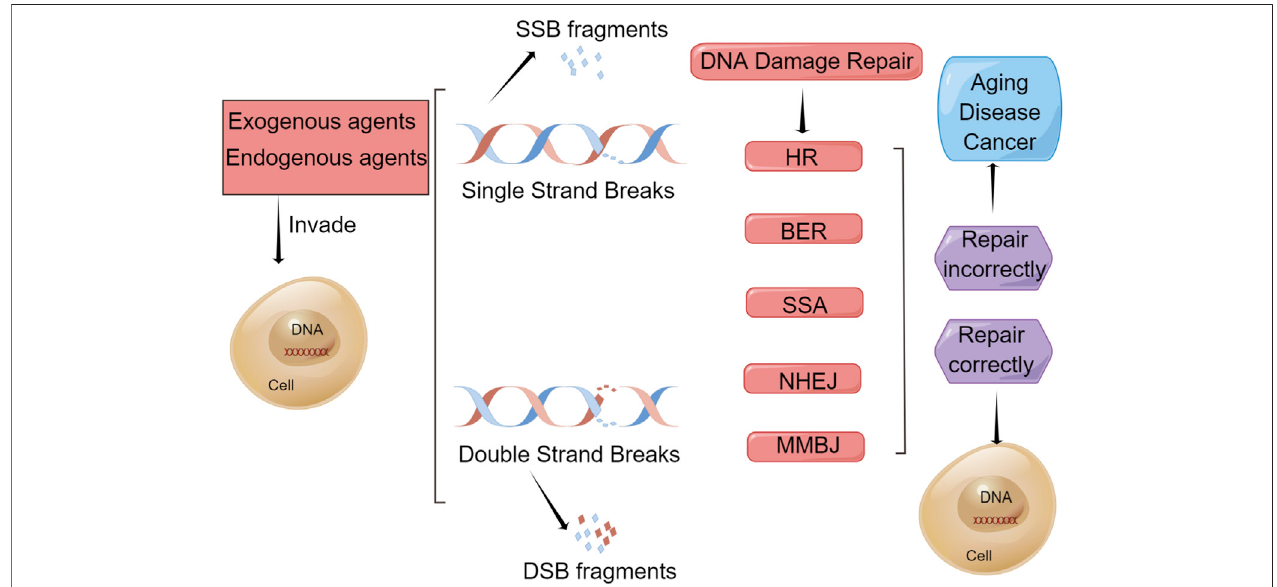
FIGURE 1 | Repair methods and outcomes of DNA damage. Endogenous and exogenous factors can damage DNA in a cell, such as reactive oxygen species (ROS) generation, replication fork stalling, chemical agents, ultraviolet radiation, and ionizing radiation, which cause single-strand breaks (SSBs) and double-strand breaks (DSBs) to produce SSB fragments and DSB fragments, respectively. To mitigate this damage, cells have evolved certain types of DNA damage repair (DDR) mechanism.BERisusedtorepairSSBsandHR,NHEJ,MMEJ,andSSAareusedtorepairDSBs.Ifrepairedcorrectly,thecellwillremainahealthycell.However,if repaired incorrectly, these cells will undergo senescence and apoptosis, leading to aging, disease, and